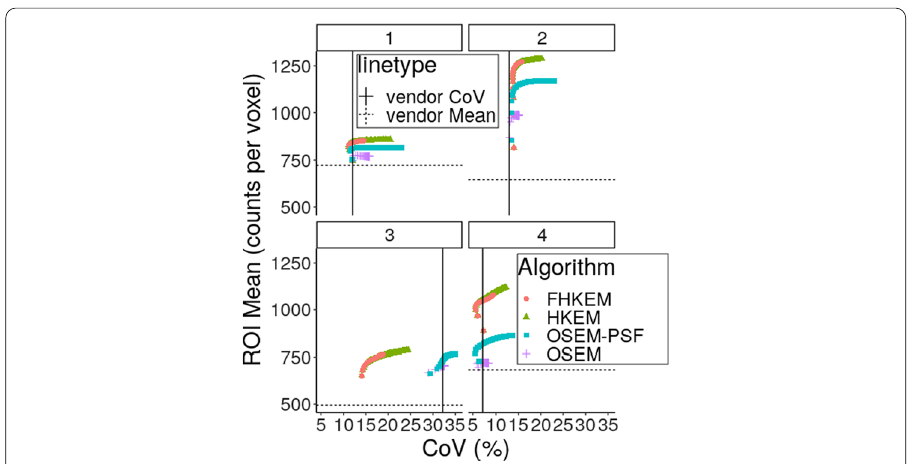
Fig. 7 ROI Mean comparison between OSEM, OSEM‑PSF, HKEM and FHKEM frozen at the 72nd sub‑iteration for the hottest lesion of 4 different patients. The black vertical and horizontal lines represent respectively the CoV and the mean value estimated on the vendor reconstructed image at iteration 2